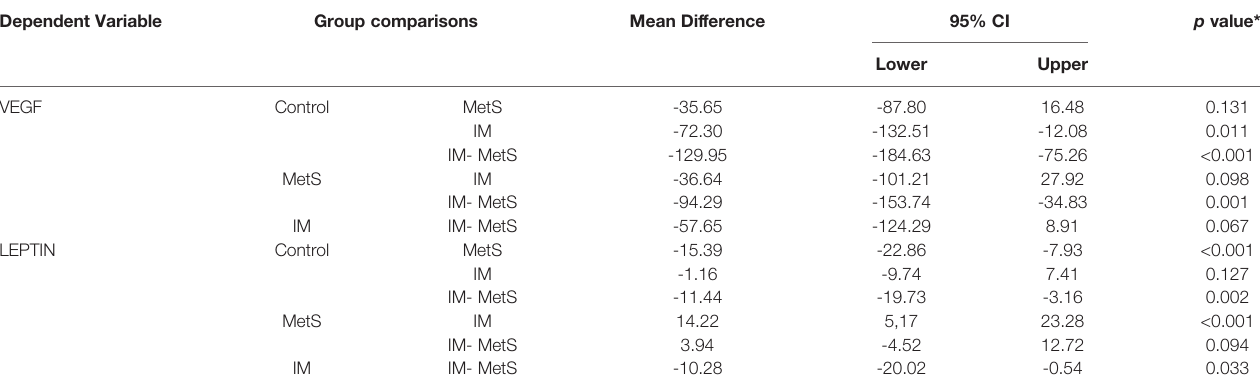
TABLE 4 | In-group analysis of VEGF and Leptin values.